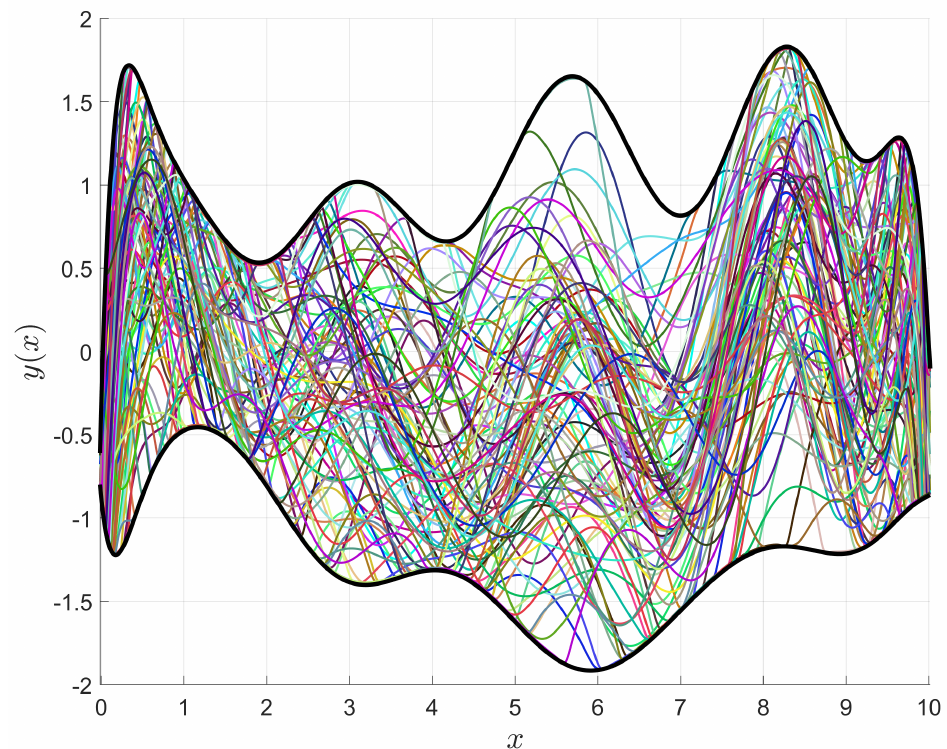
Figure 7. Random constrained expressions with continuous bounds.